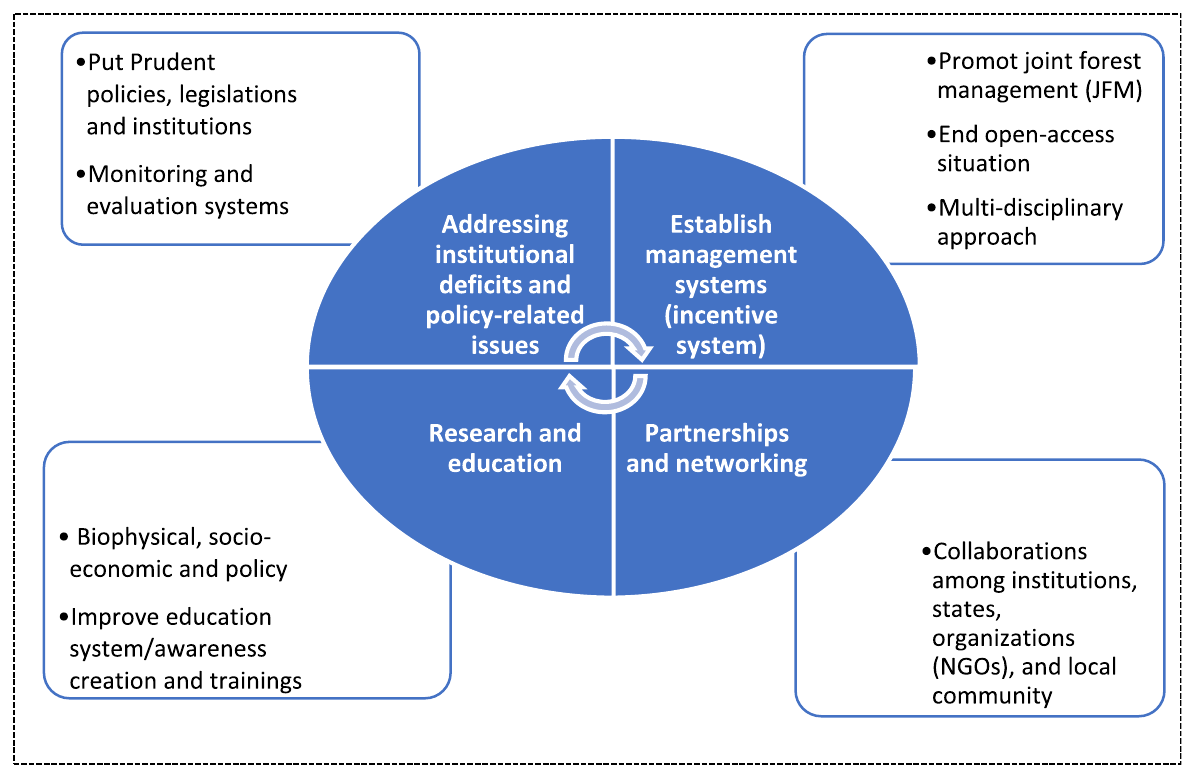
Fig. 4 Framework for integrated efforts and partnerships towards realizing sustainable TDF